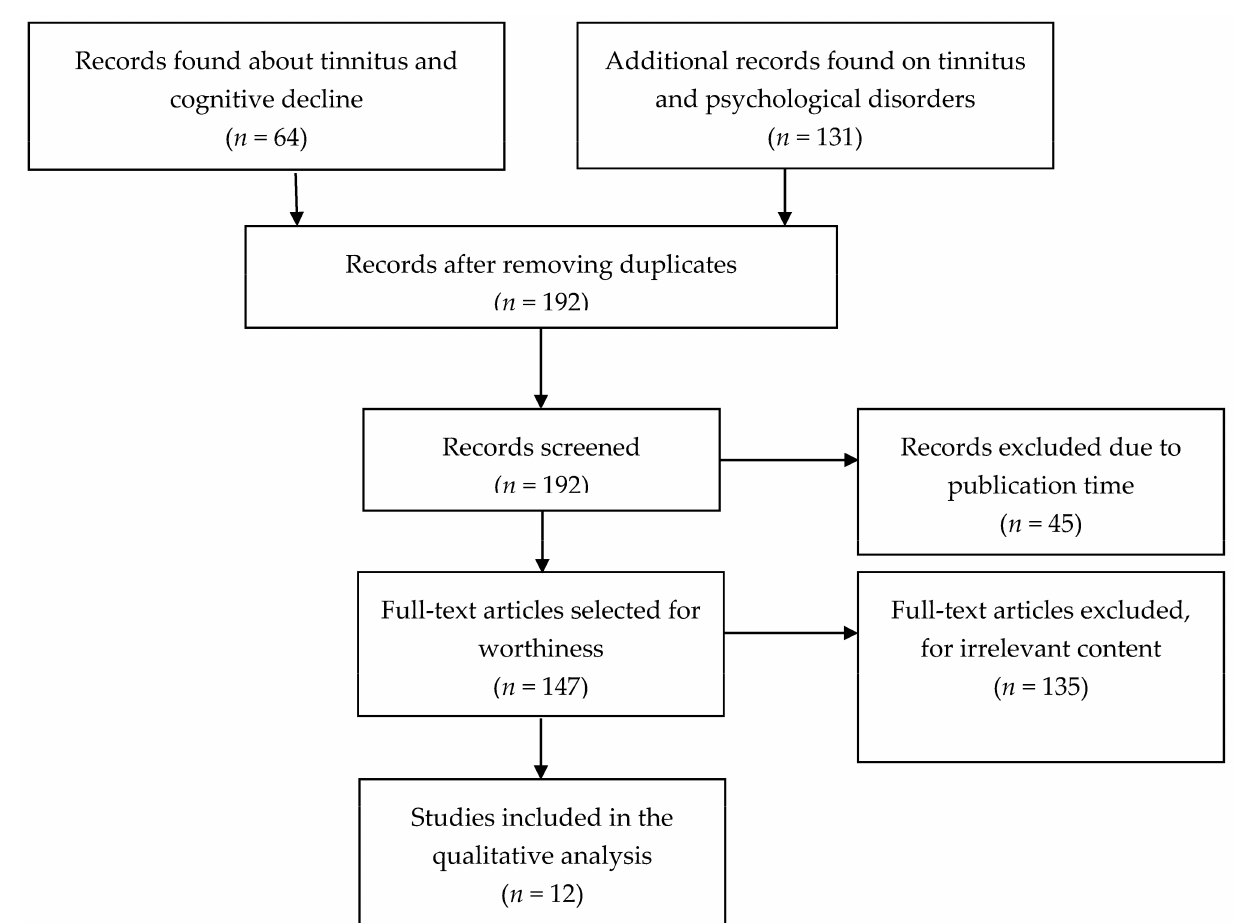
Figure 1. PRISMA flow diagram. The flowchart displays article search and